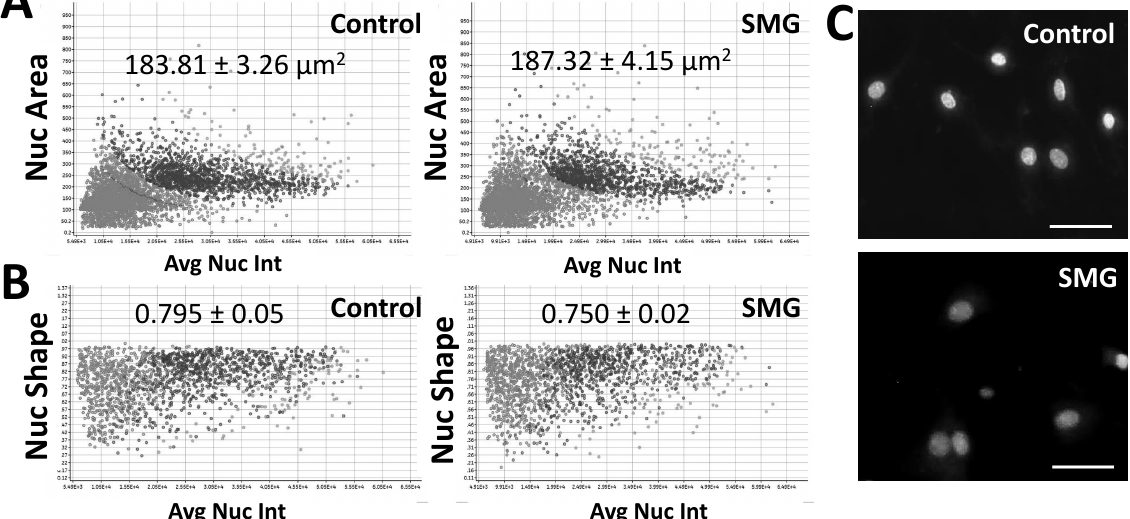
Figure 3. Nuclear morphology analysis of pGCs. ( A ) The distribution of the nuclear area in relation to nuclear intensity; ( B ) the distribution of the nuclear shape value in relation to nuclear intensity; ( C ) nuclei were counterstained with H33342. Scale bar = 25 µ m.